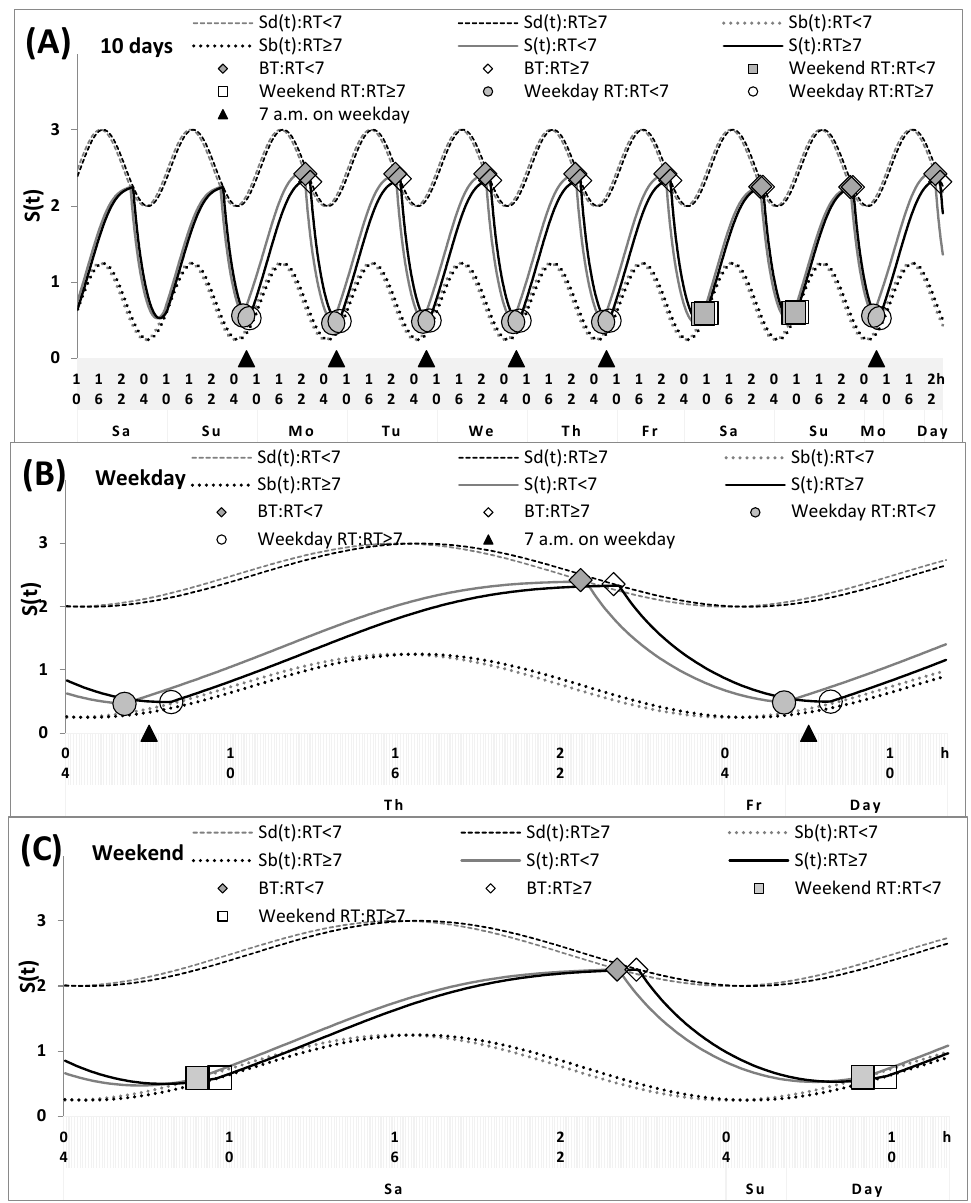
Figure 1. Simulations of the sleep–wake cycles of early and late risers. Simulations of the whole sequence of 10 sleep–wake cycles ( A ), and two subintervals for a weekday and a weekend, ( B , C ), respectively, for the participants with different weekday risetime (RT), either <7 or ≥ 7 a.m. See Table 3 and Figure 4 (left graphs) for the comparison with sleep times self-reported by lecturers. The sequence of 10 sleep–wake cycles includes two last free days (e.g., at the end of a hypothetical vacation), the following week consisting of five weekdays and two weekends, and the first weekday of the next week (i.e., Sa-Su, Mo-Fr, Sa-Su, and Mo are the days of the week, namely, Saturday, Sunday, Monday, Tuesday, Wednesday, Thursday, Friday). S ( t ): Alternations between buildup and decay phases of the process of sleep–wake regulation. The parameters of these buildups and decays are modulated by a sine-form function with a 24 h period (i.e., this function represents the circadian pacemaker). Sd ( t ) and Sb ( t ): The time course of predicted highest and lowest buildups and decays of S ( t ), respectively. The simulations suggested that, in general, the parameters of the sleep–wake regulatory processes may be practically identical in two subdivisions with RT either <7 a.m. or ≥ 7 a.m. The only postulated differences were in sleep times on free days and in an advance in weekday waking times relative to free day waking times. The latter difference led to the difference in the timing of light exposure on weekdays and, as a consequence, to the difference in the circadian phase (0.7